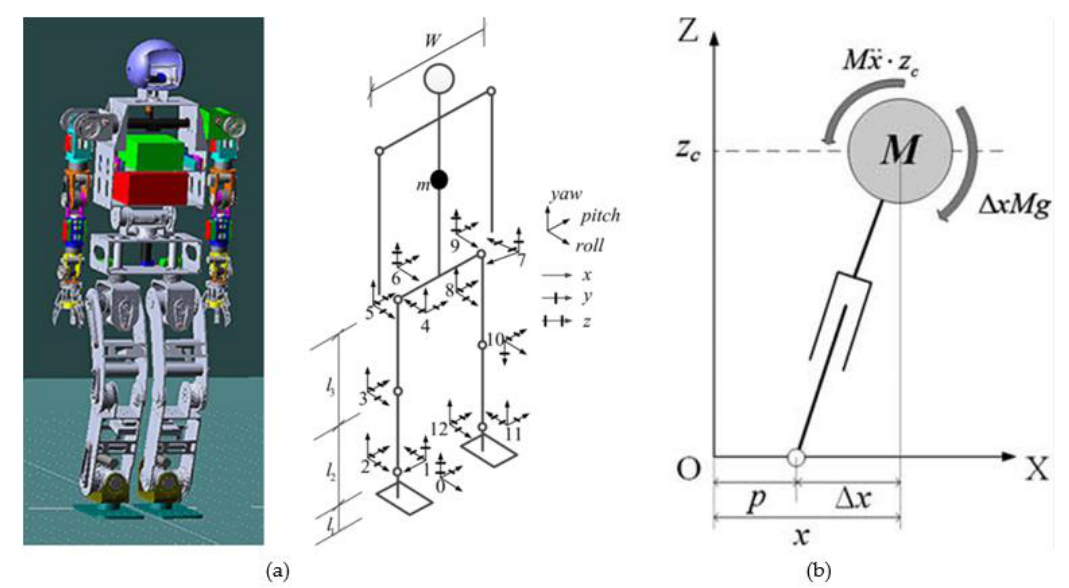
Figure 4. The model-based gait planning ( a ) The multi-link model; ( b ) The inverted pendulum model. (( a ) was reproduced with permission from [63]; ( b ) was reproduced with permission from [64], Copyright Cambridge University Press, 2016.)